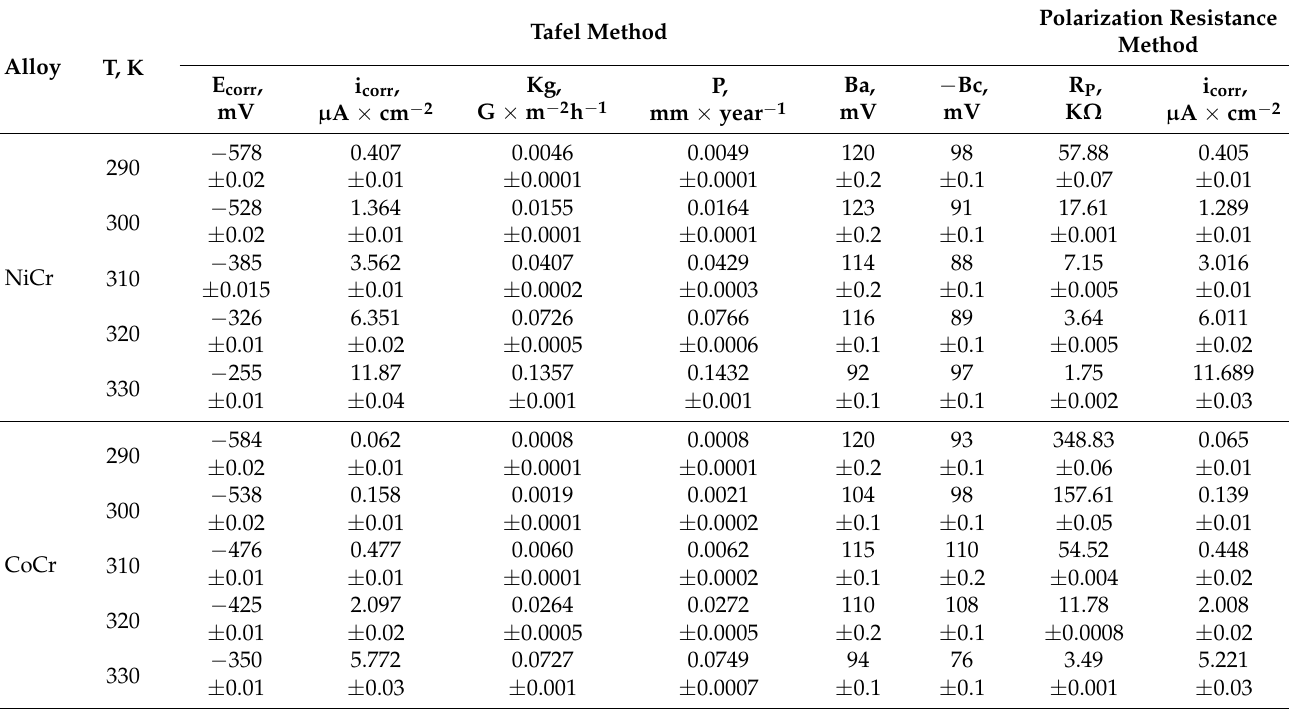
Table 2. Kinetic corrosion parameters of NiCr and CoCr alloys at different temperatures of Fusayama–Meyer artificial saliva.